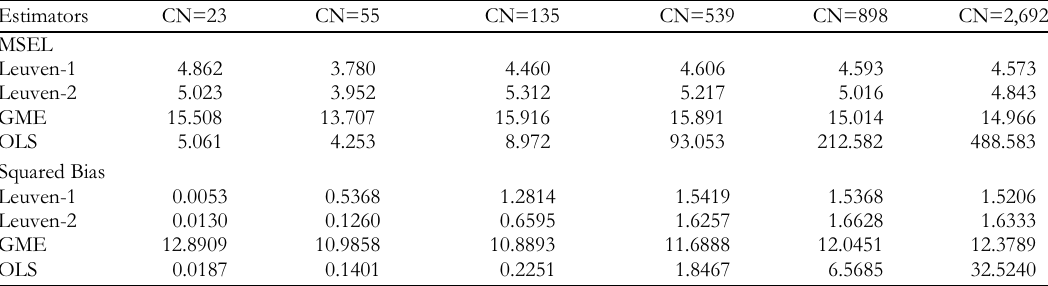
Monte Carlo experiment N. 2: model with intercept. MSEL and squared bias of rival estimators for an increasing condition number. T=50, 100 samples Estimators CN=23 CN=55 CN=135 CN=539 CN=898